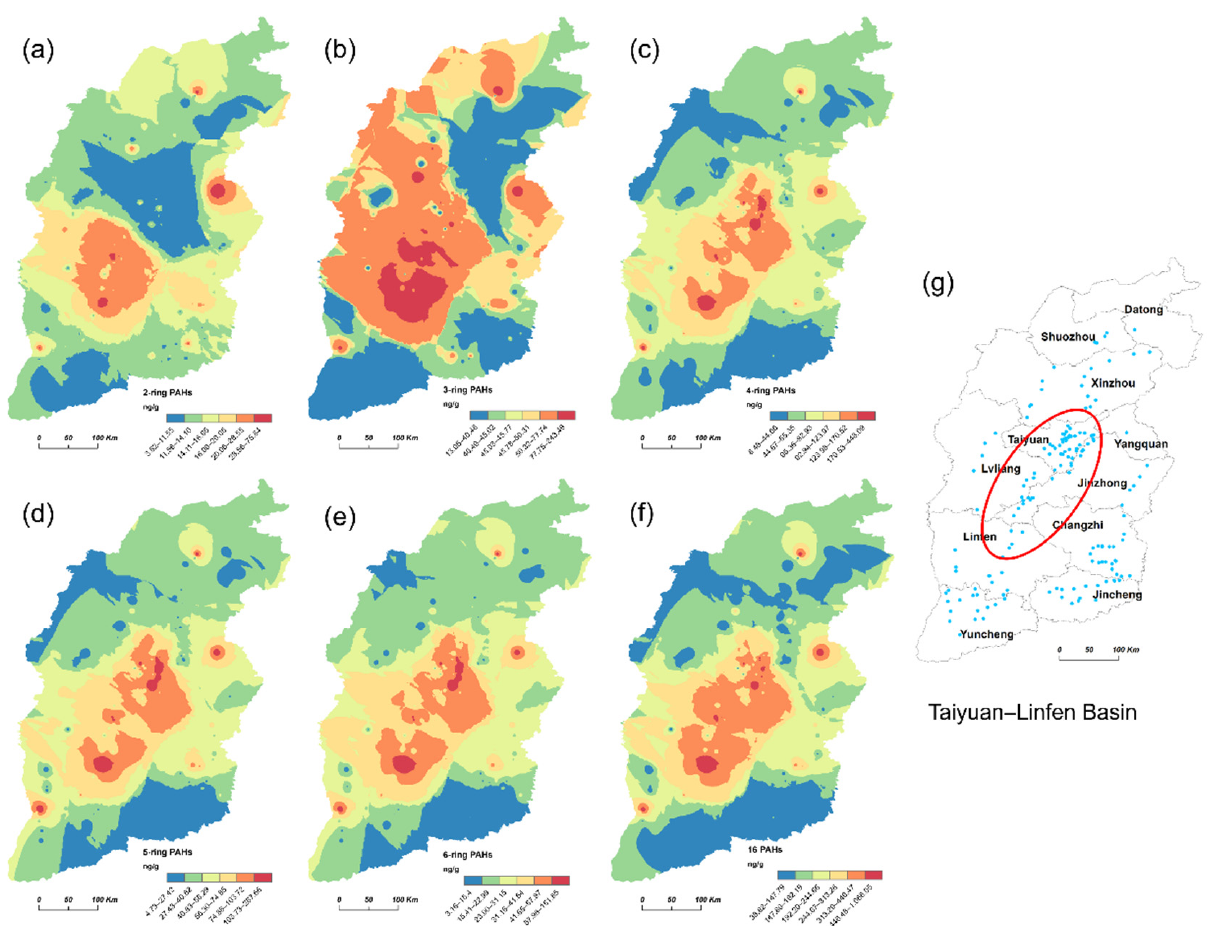
Figure 3. Spatial distribution pattern of soil ∑ 16 PAHs and PAHs with different ring numbers in Shanxi Province. ( a ) 2-ring PAHs; ( b ), 3-ring PAHs; ( c ) 4-ring PAHs; ( d ) 5-ring PAHs; ( e ) 6-ring PAHs; ( f ) ∑ 16 PAHs; ( g ) location of Taiyuan–Linfen Basin. Table 2. Spatial autocorrelation analysis of the soil ∑ 16 PAHs and PAHs with different ring numbers. PAHs Moran’s I p -Value z-Score Significance Spatial Correlation 0.09 0.06 1.85 Significant Clustered 0.90 Not significant Random Significant Clustered 1.57 Not significant Random 0.09 1.68 Significant Clustered 1.44 Not significant